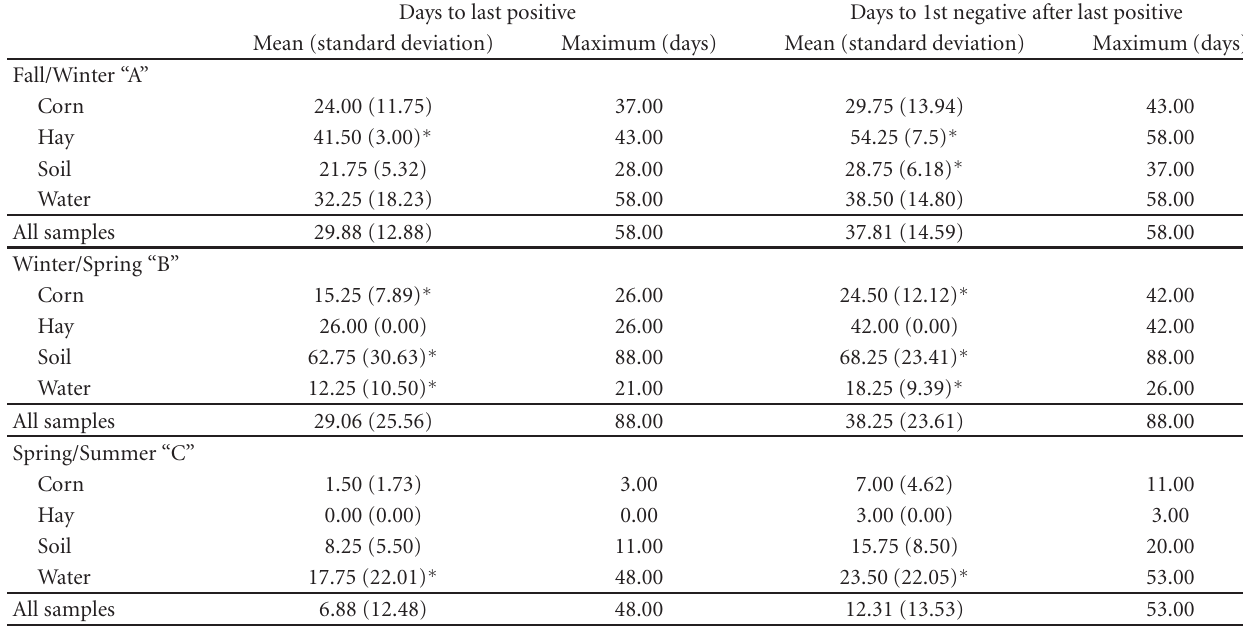
Table 2: Duration of M. bovis persistence in the environment on corn, hay, water and soil samples in season “A”, “B” and